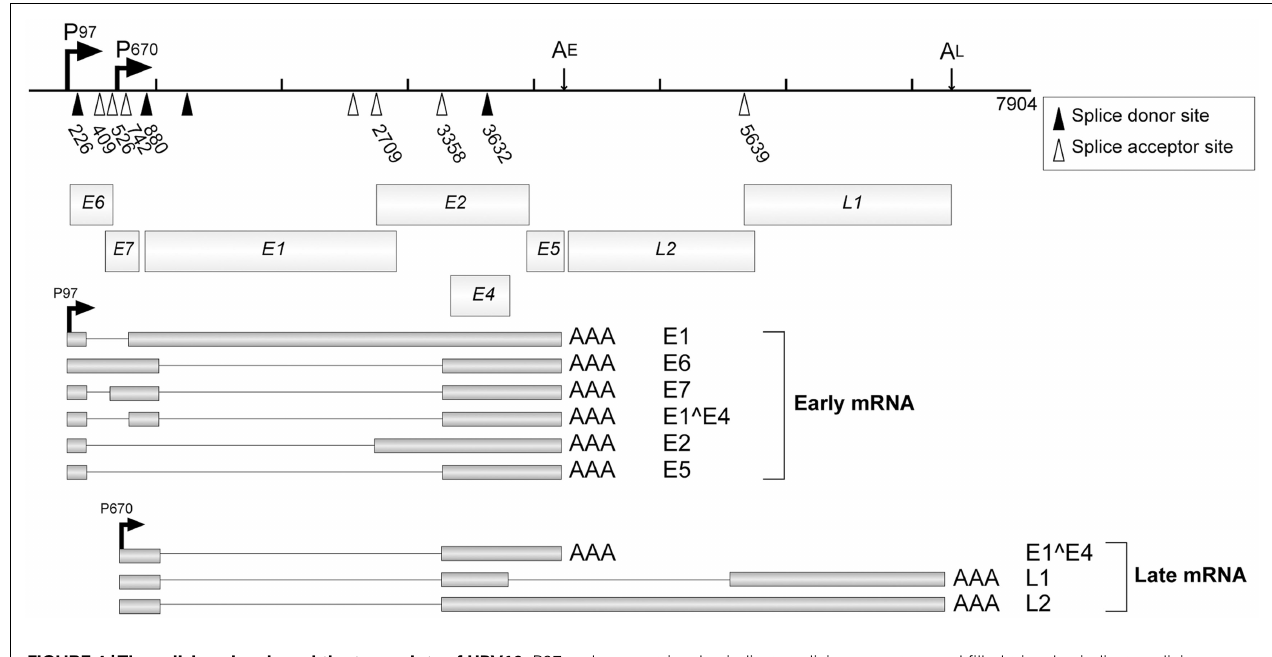
FIGURE 4 |The splicing signals and the transcripts of HPV16. P97 and P670 are the early and late promoters, respectively, for HPV16. AE and AL indicate the early and late polyadenylation signals, respectively. Open